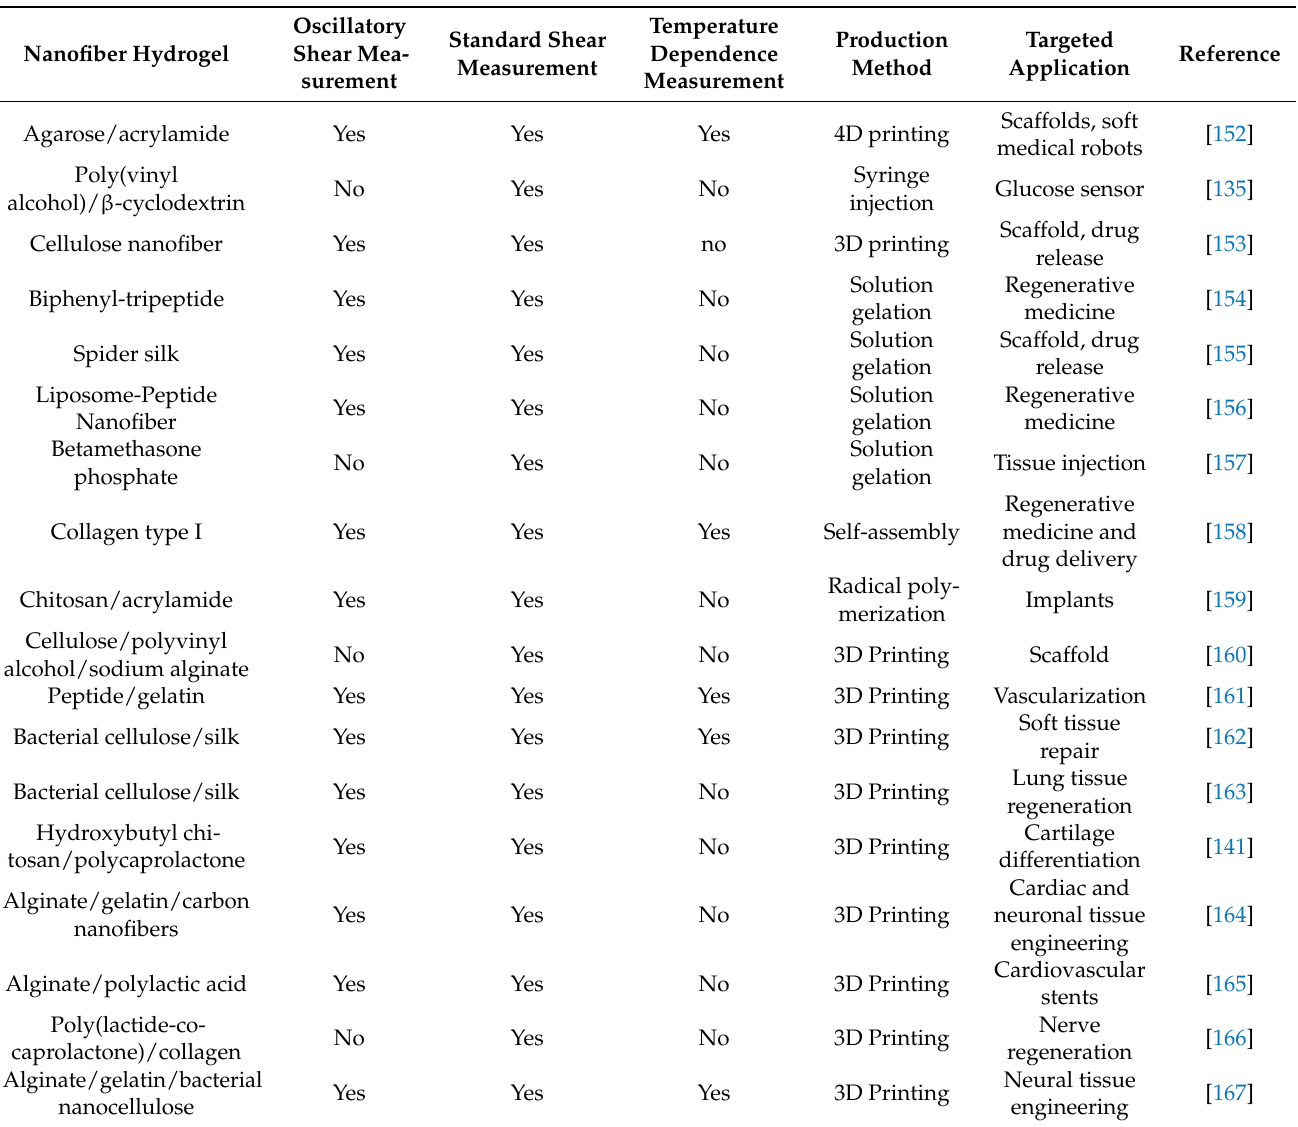
Table 3. Rheological studies on nanofiber hydrogels are extremely important for effective 3D and 4D printing applications. Oscillatory shear measurements as well as standard temperature dependence measurements are needed for thixotropic gel